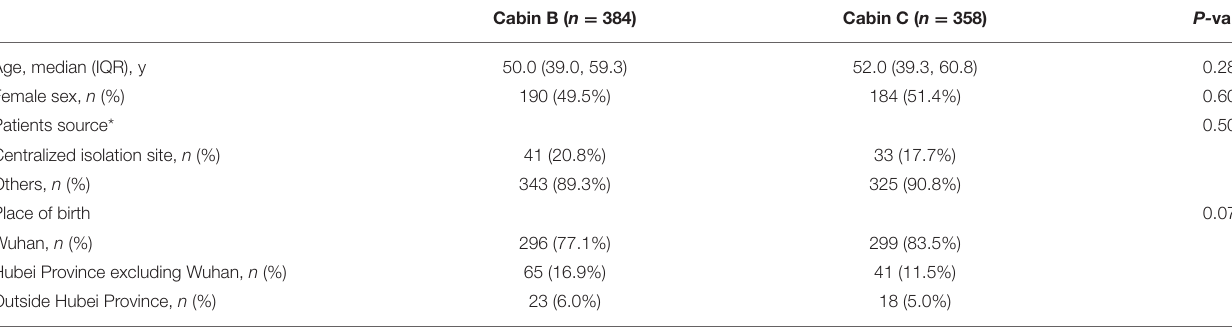
TABLE 1 | Demographic and source of patients in cabins B and C of Dongxihu FangCang Hospital before random